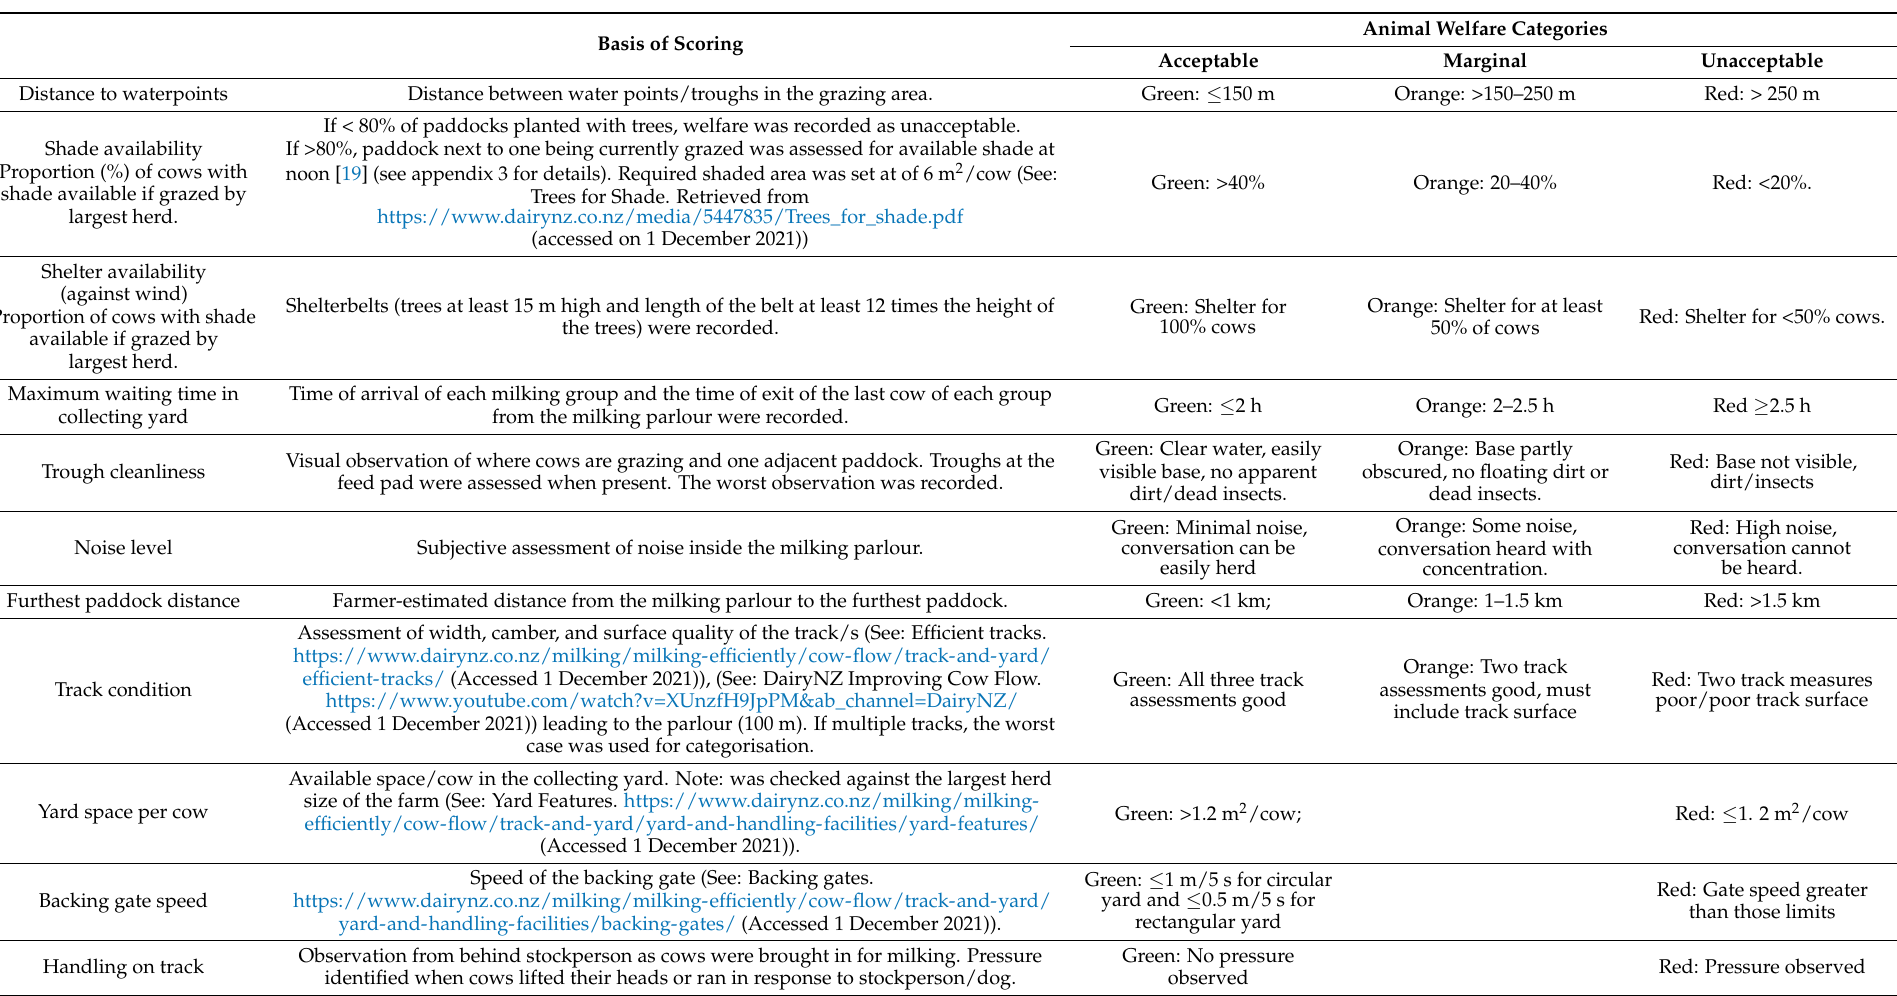
Table 2. Method of assessment for resources and stockperson-based measures from the pasture-based dairy cattle welfare assessment protocol, with categorisation based on author-determined